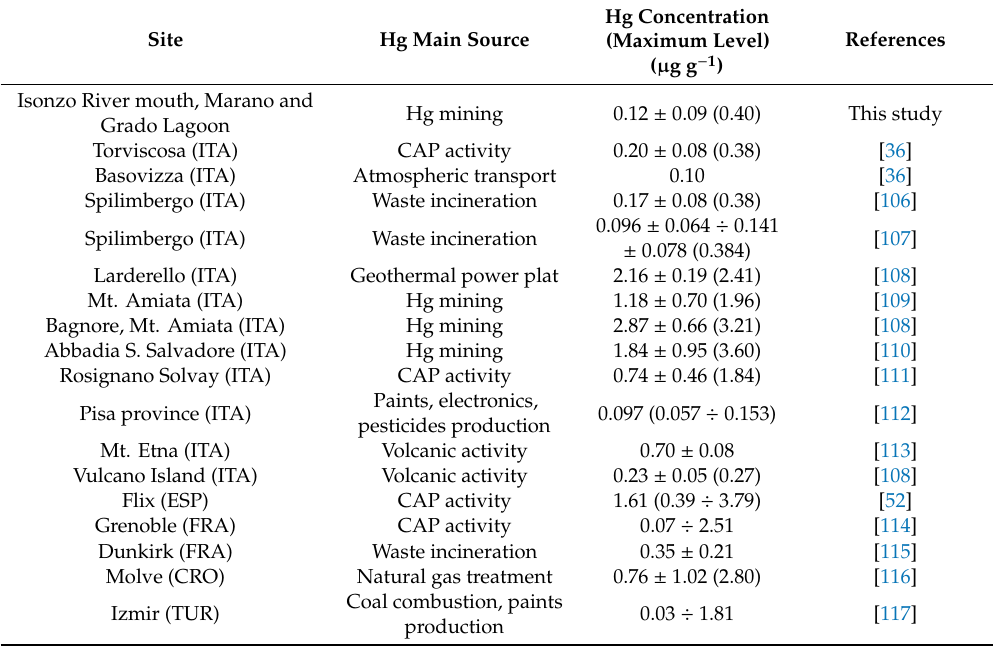
Table 3. Total Hg levels observed in monitoring conducted in di ff erent sites with the species X. parietina .